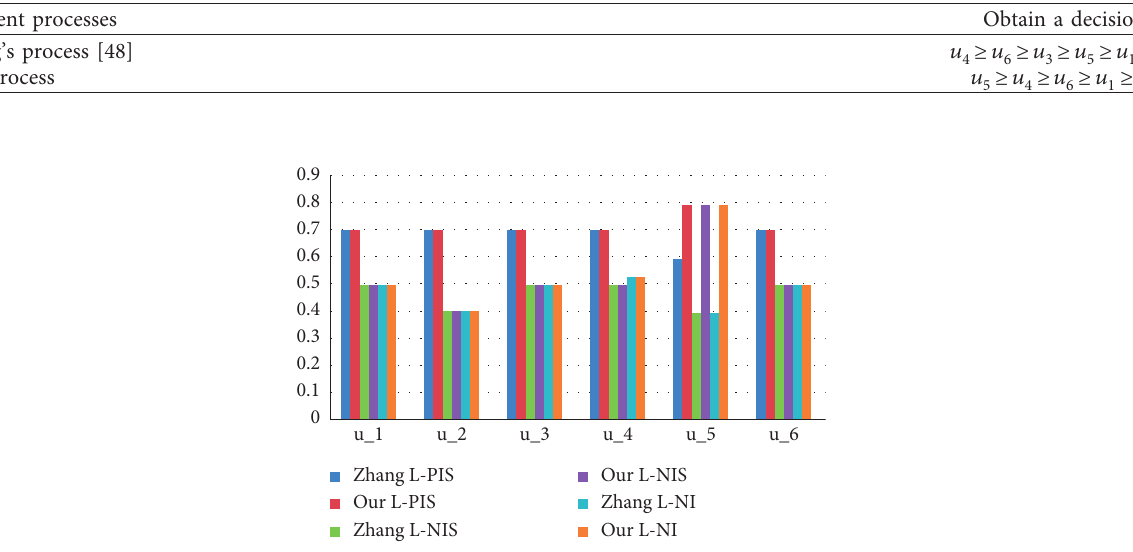
Figure 1: The lower approximation using our model and Zhang et al.’s [48] model.